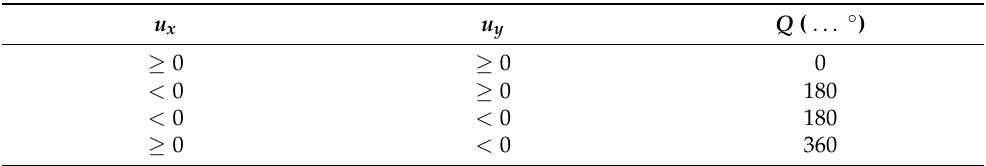
Table 1. The Quadrant parameters in Equation